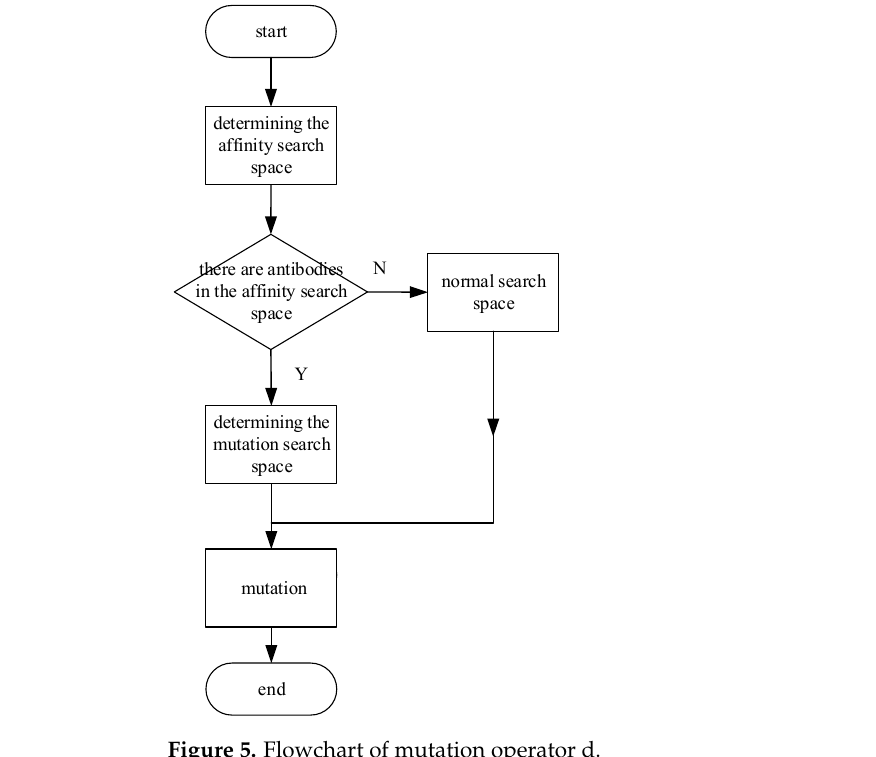
Figure 4. The mutation process of the mutation operator 𝑐 .